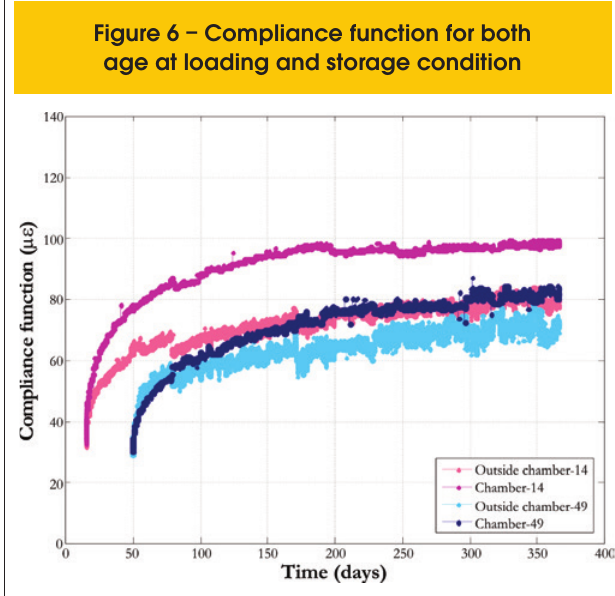
Figure 6 – Compliance function for both age at loading and storage condition